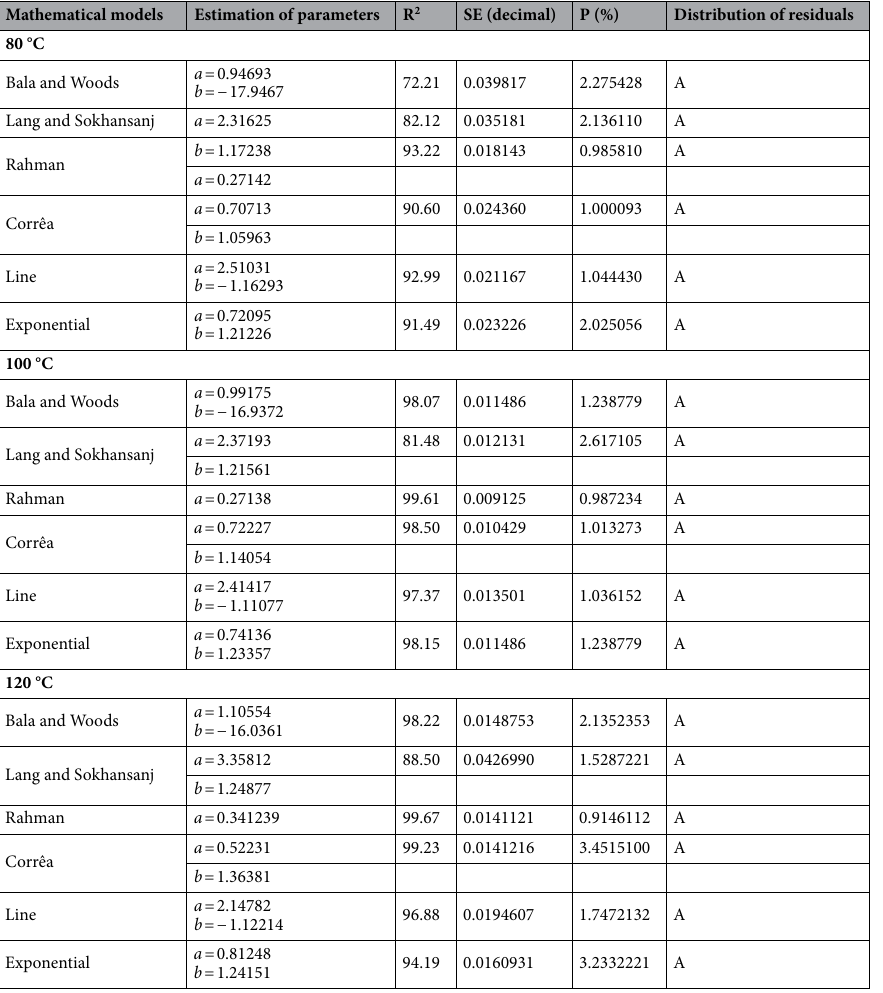
Table 5. Parameters estimated, coefficient of determination (R 2 ), estimated average (SE) and relative error (P) and distribution of residues of the mathematical models used to describe the shrinkage of soybeans grains to different drying air temperatures and an initial moisture content of the grains of 23%